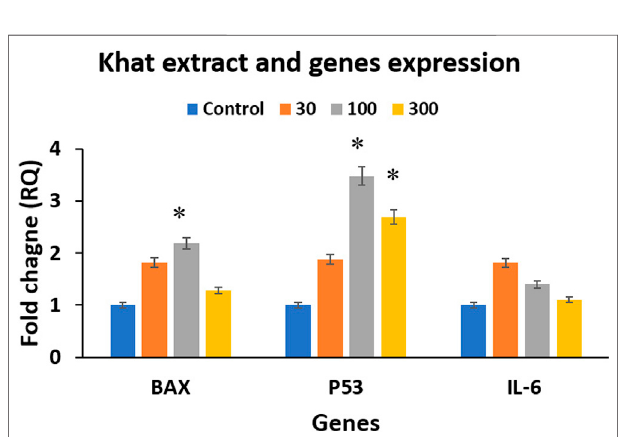
FIGURE 5 | Gene expression analysis using RT-qPCR analysis of the treated and untreated SKOV3 cells showing BAX, p53, and IL-6 expression following treatment with 30, 100, and 300 μ g/ml of khat extracts for 48 h. GAPDH was used as the internal control, and the data were quanti fi ed using the comparative 2 − ΔΔ Ct method. The values are expressed as mean ± SEM from triplicate samples of two independent